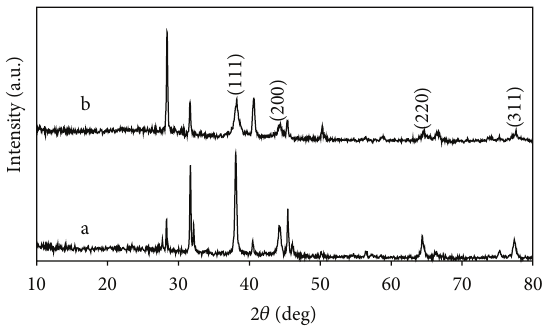
Figure 2: XRD patterns of Ag NPs (a) and Au NPs (b).